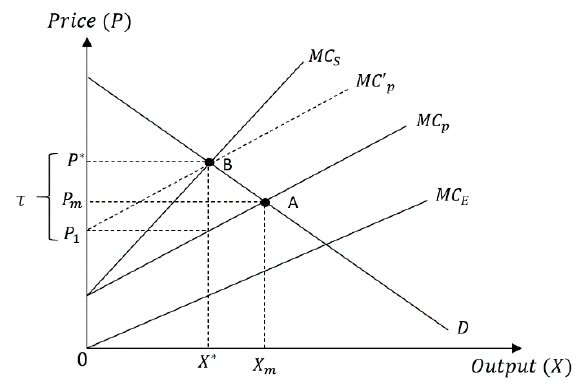
Figure 3. Pigouvian tax correction for a negative externality of emissions.